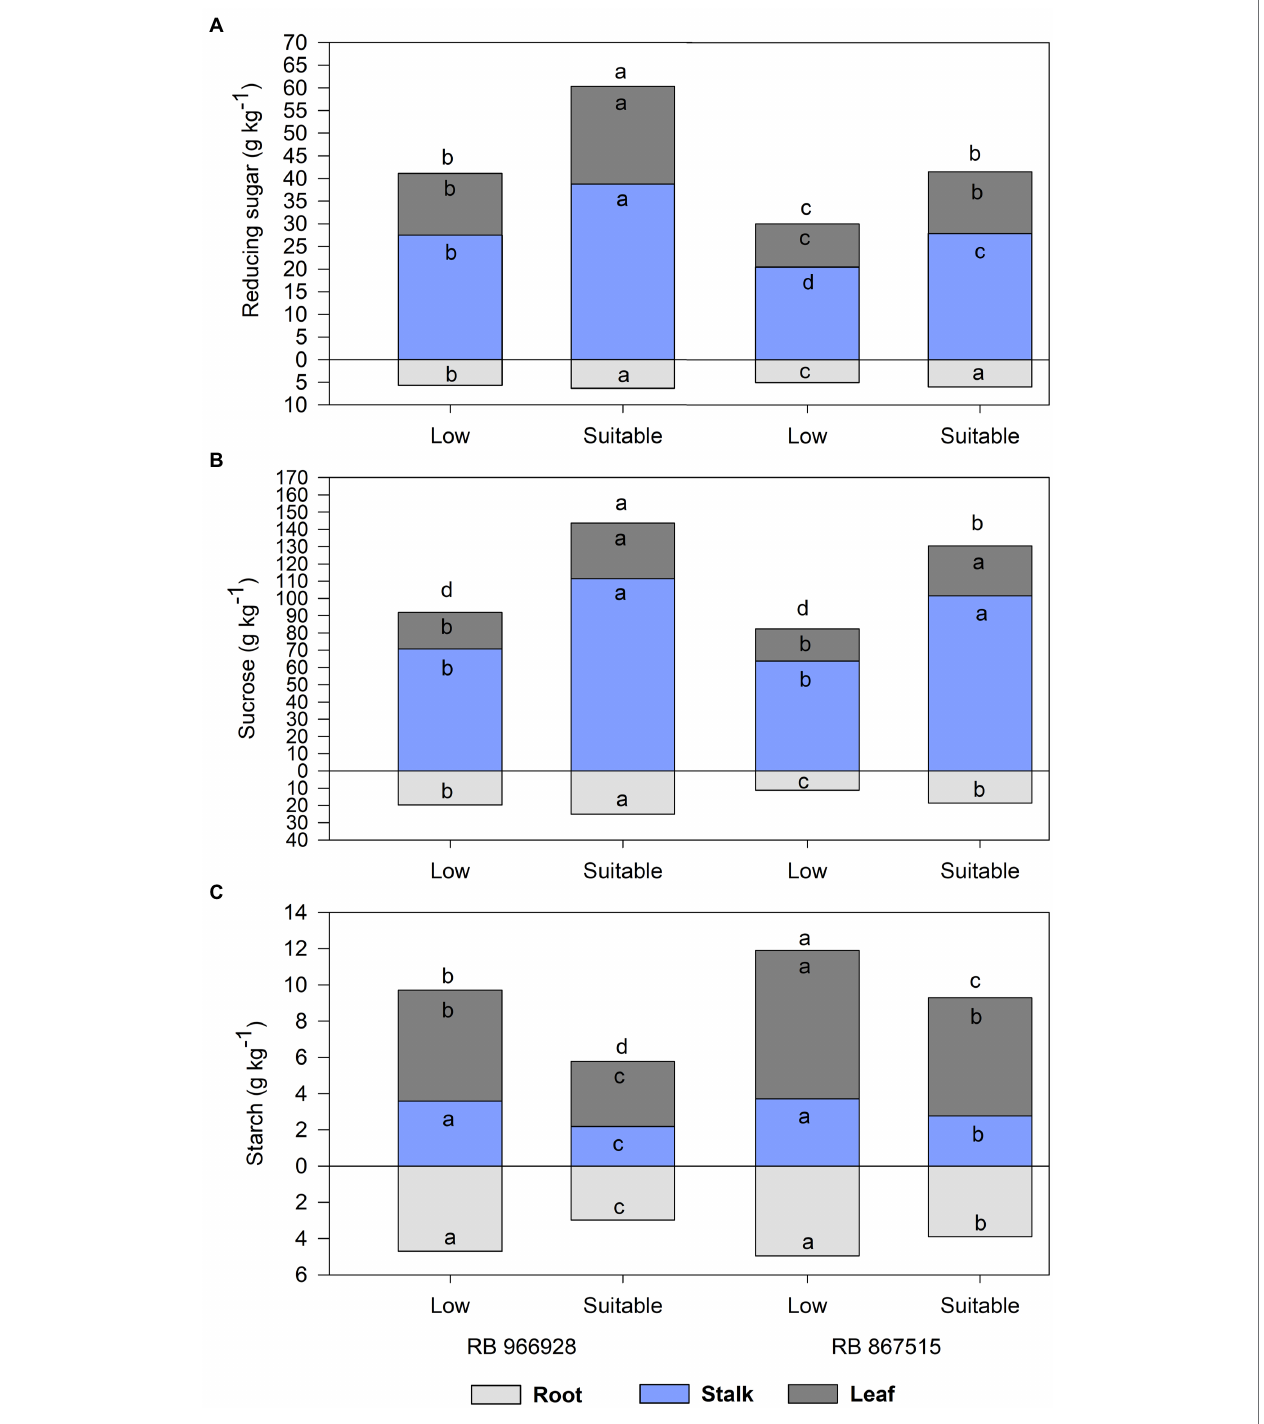
FIGURE 1 | Carbohydrate partitioning into (A) reducing sugars, (B) sucrose, and (C) starch in different plant parts as a function of sugarcane RB966928 and RB867515 varieties and low and suitable phosphorus (P) levels. Different letters for the same plant part indicate significant differences between sugarcane variety and P level by Student’s t -test at p ≤